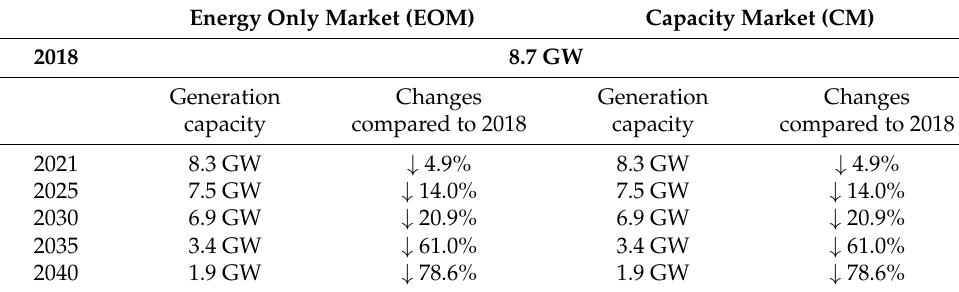
Table 5. Generation capacity in lignite-fired power generation